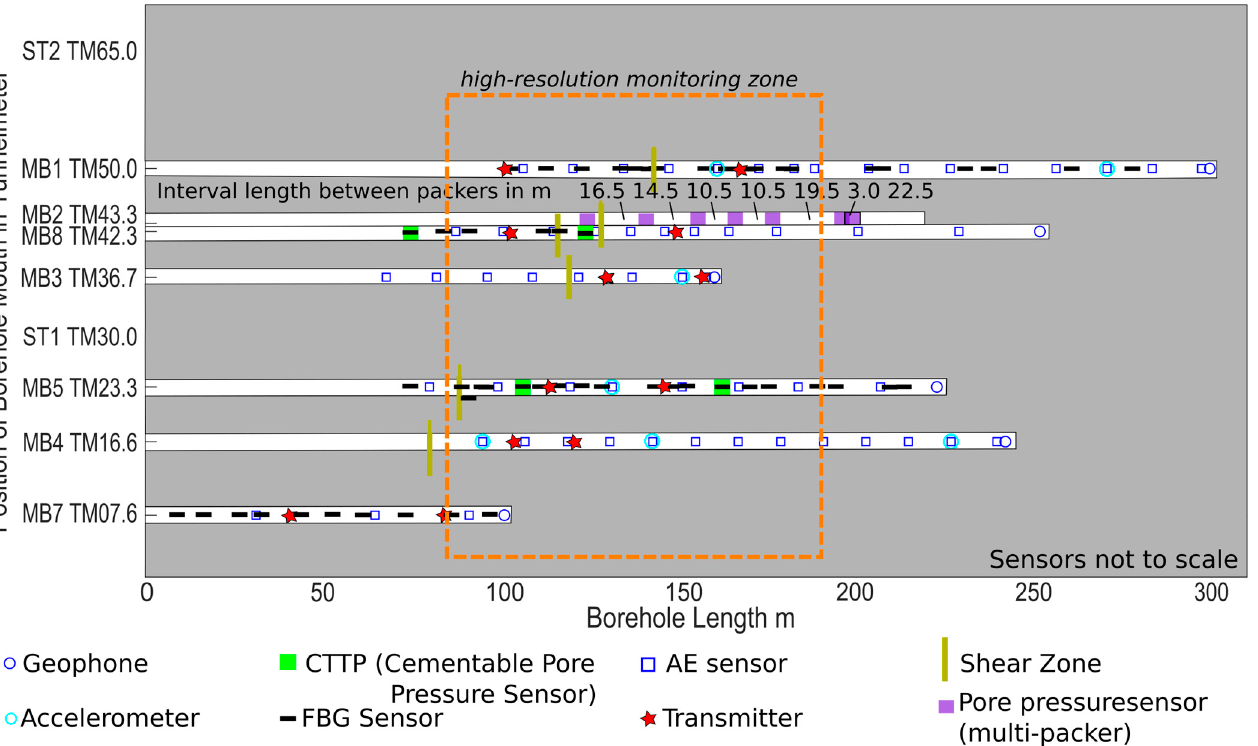
Figure 5. Final sensor positions inside the long monitoring boreholes in the BRP. Monitoring boreholes are sorted regarding the location of the borehole mouth in tunnel meters (TMs). For the borehole geometry see Figure